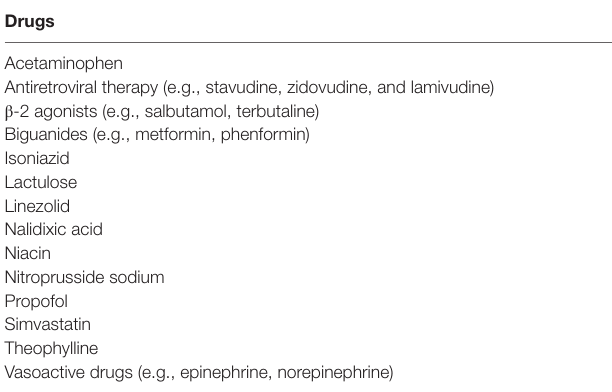
taBLe 1 | Drugs associated with type B lactic acidosis. Drugs